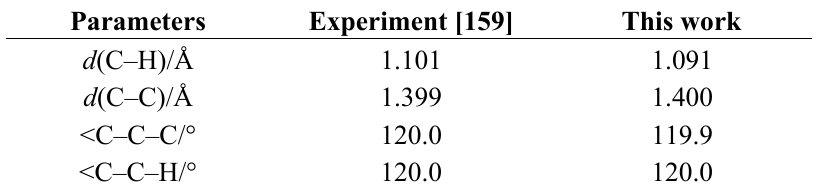
 O (01 1 2) surface with GGA+U = 5 eV. The Fermi 2 3